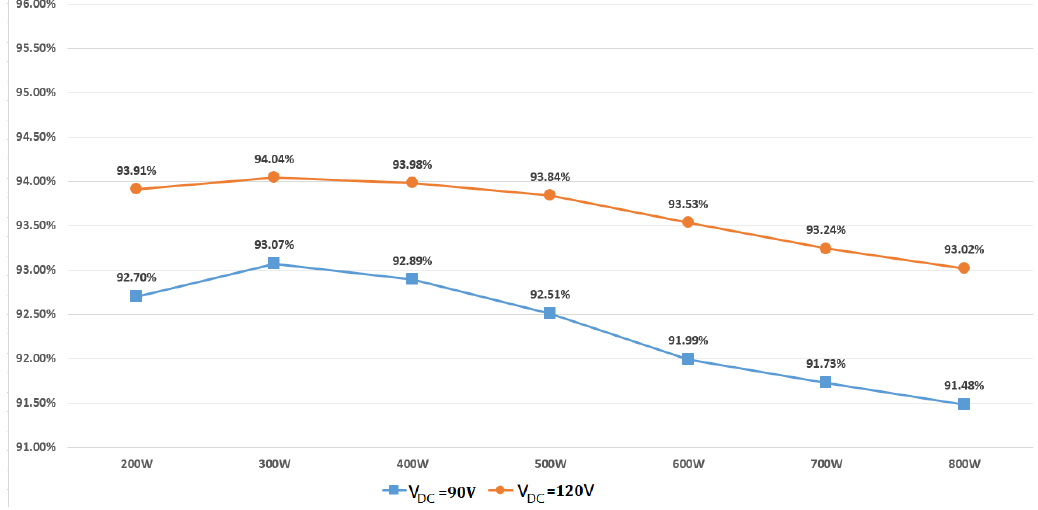
Figure 15. Experimental results of the BBI under the transient of input DC voltage variation, ( a ) input DC voltage, ( b ) output current, ( c ) current of inductor L 1 .